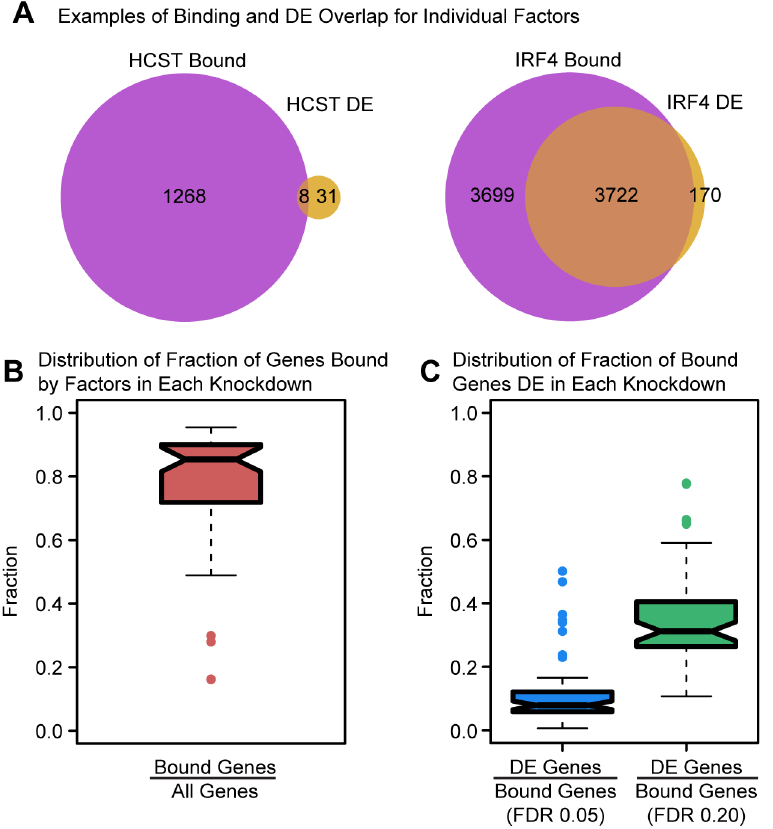
Figure 3. Intersecting binding data and expression data for each knockdown. (a) Example Venn diagrams showing the overlap of binding and differential expression for the knockdowns of HCST and IRF4 (the same genes as in Figure 1). (b) Boxplot summarizing the distribution of the fraction of all expressed genes that are bound by the targeted gene or downstream factors. (c) Boxplot summarizing the distribution of the fraction of bound genes that are classified as differentially expressed, using an FDR of either 5% or 20%.